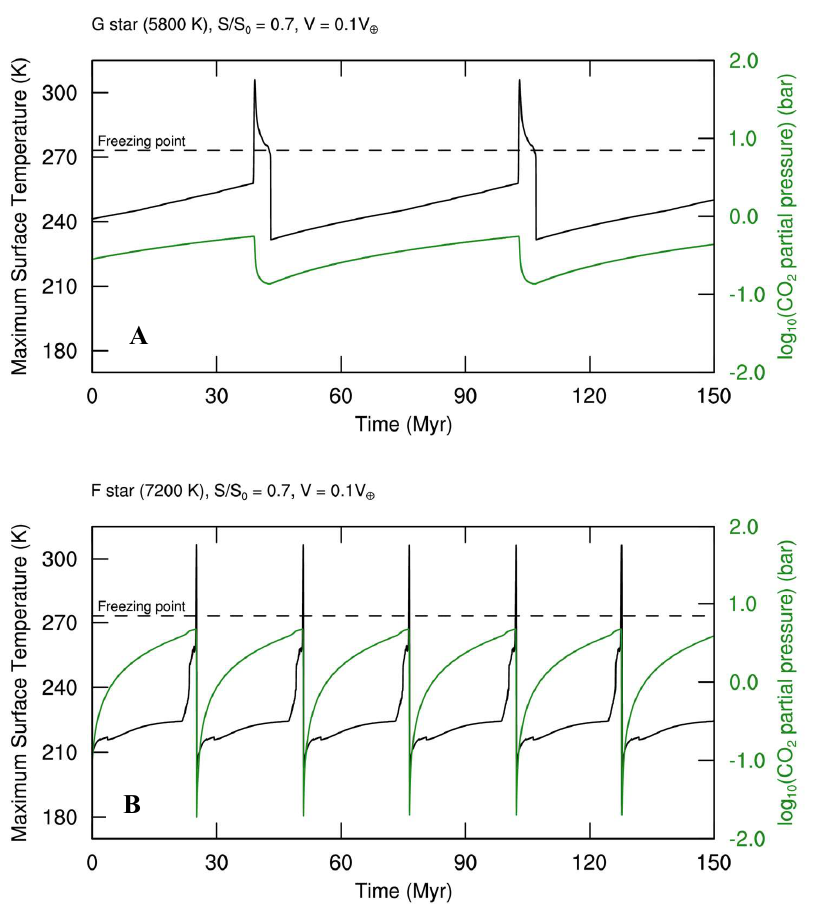
Figure 4. Maximum surface temperature (black curve) and pCO 2 level (green curve) for an Earth-like planet with a volcanic outgassing rate 10% of that of Earth’s orbiting a G-star ( A ) and F-star ( B ) for S EFF = 0.7. Transient periods of warming during which temperatures exceeding the freezing point of water (dashed line) are followed by extended periods of global glaciation (adapted from Haqq-Misra et al. [79]). Haqq-Misra et al. [79] argued that this mechanism decreases HZ width on planets with low volcanic outgassing rates. Although it may be possible that limit cycles occur on some exoplanets [76,80], this particular result is a direct prediction of the carbonate–silicate cycle and does not depend on the occurrence of limit